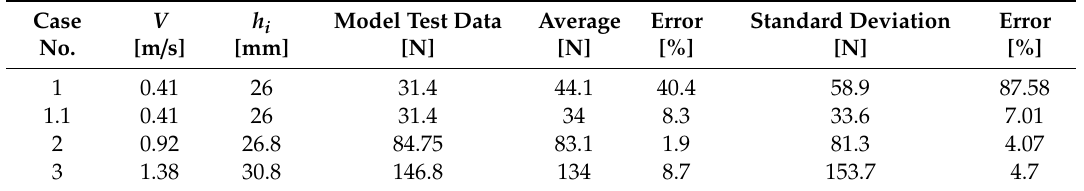
Figure 16. Case 3: Result comparison for speed V = 1.38 m/s . Table 4. Ice force result summary and comparison.